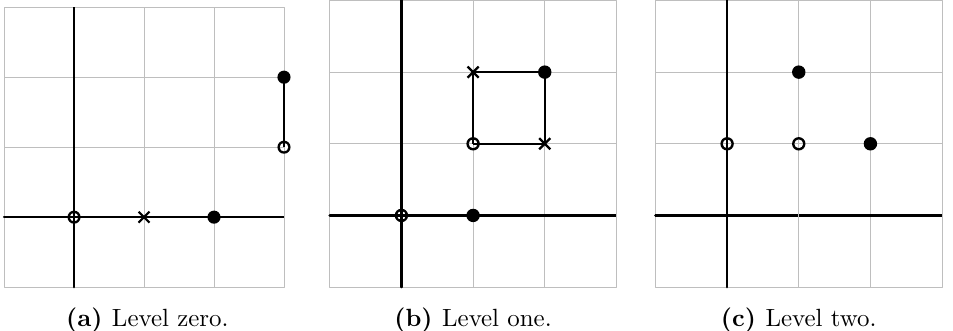
Figure 11. Exponential factors of the anti-fundamental representation in direction 1. The two crosses in the middle (cid:12)gure correspond to two possible